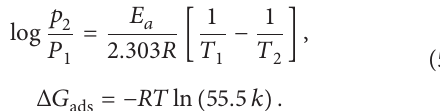
indicated ads Δ𝐺𝐺